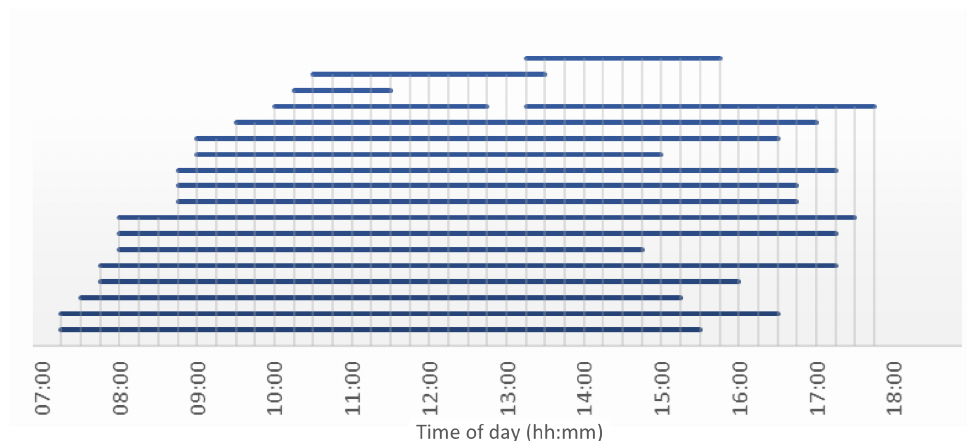
Figure 16. Parking times of a day at Royal Reesink BV in Apeldoorn. Each blue bar represents an employee who has parked their car.